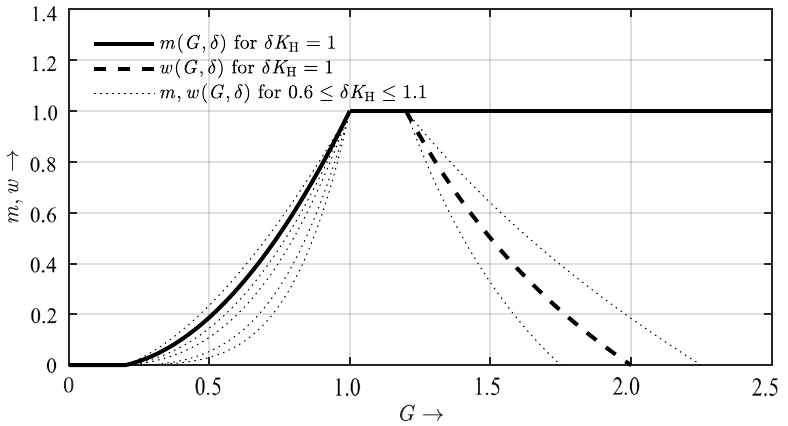
Figure 2. Characteristic arrays of curves m ( G , δ ) and w ( G , δ ) after [20] respective [21]